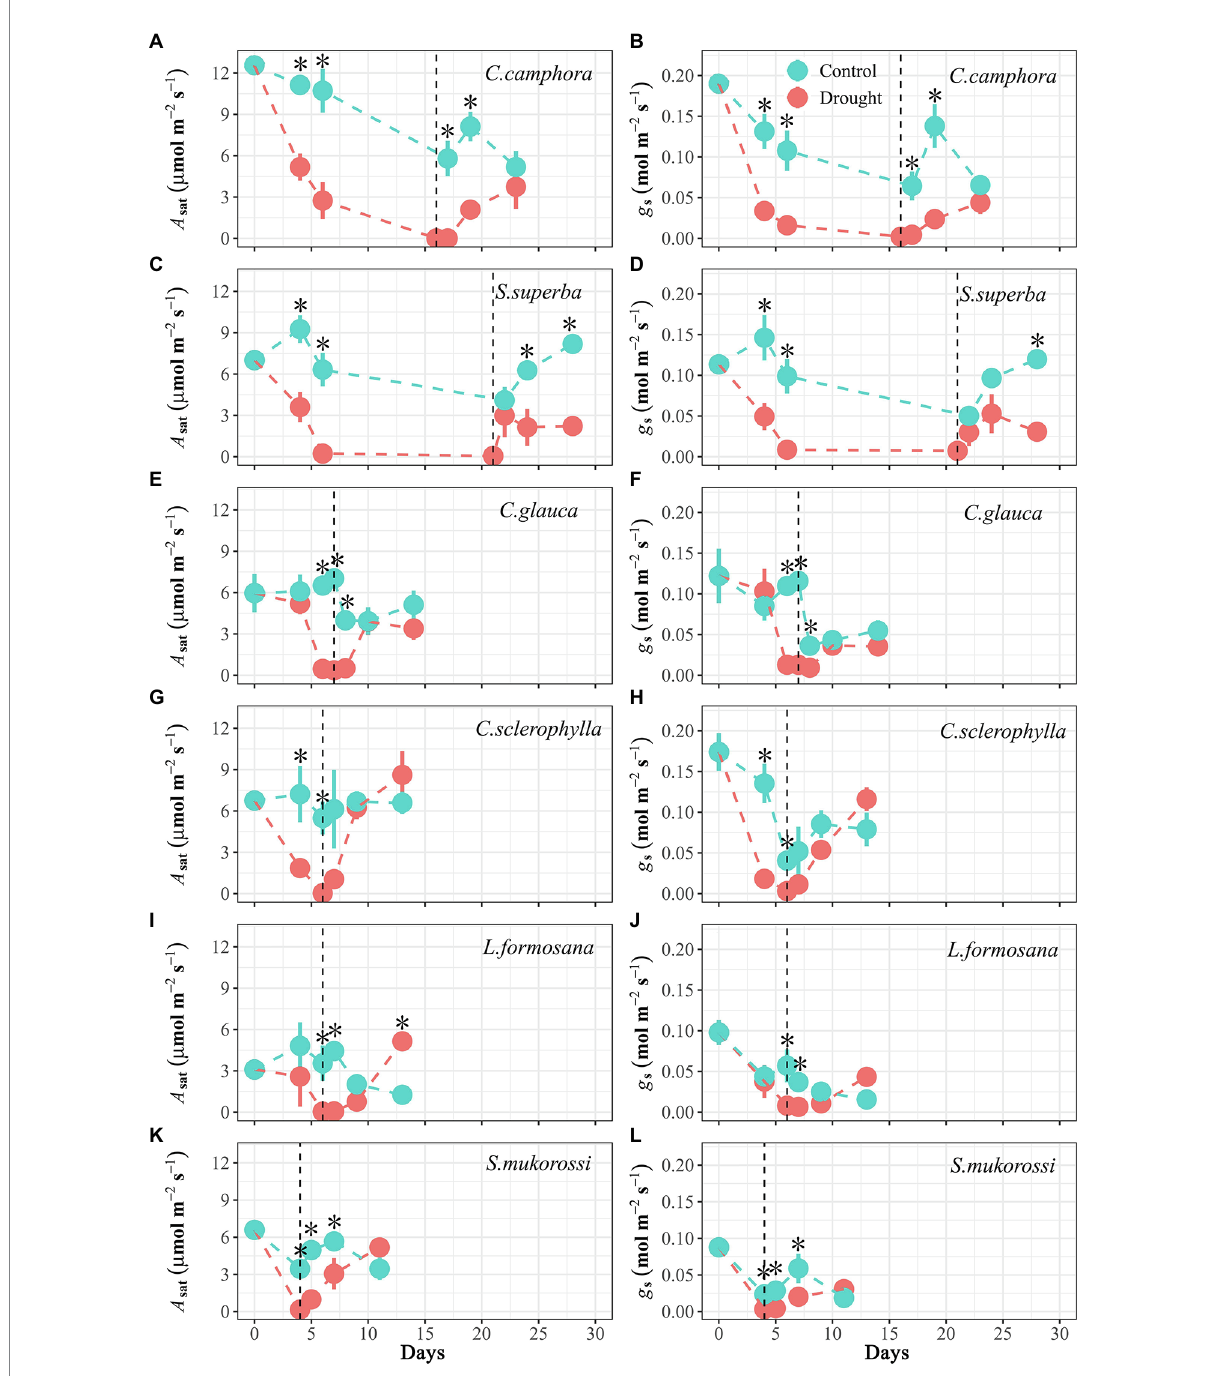
FIGURE 2 Time course of leaf photosynthesis under saturating light ( A sat ) and stomatal conductance ( g s ) for seedlings of the six tree species throughout the experimental period. Values are Means ± SE ( n = 3–5). “ * ” means significant difference ( p ≤ 0.05) for A sat or g s between Control and Drought treatments at each sampling date. Control-Well-watered control; Drought-drought and recovery treatment. The vertical lines represent the time for re-watering. The first four species are evergreen species, while the last two species are deciduous